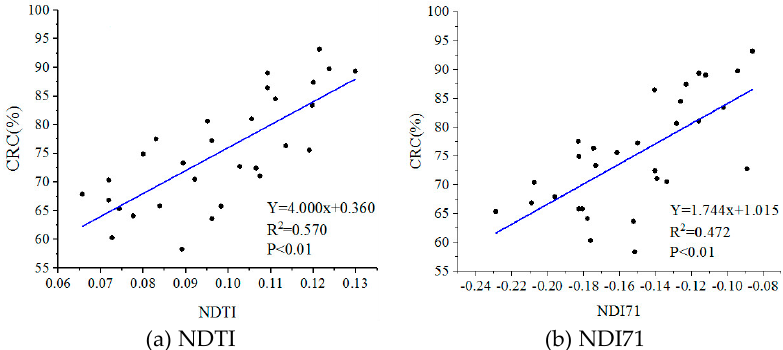
Figure 4. Regression between CRC and some optical crop residue indices.